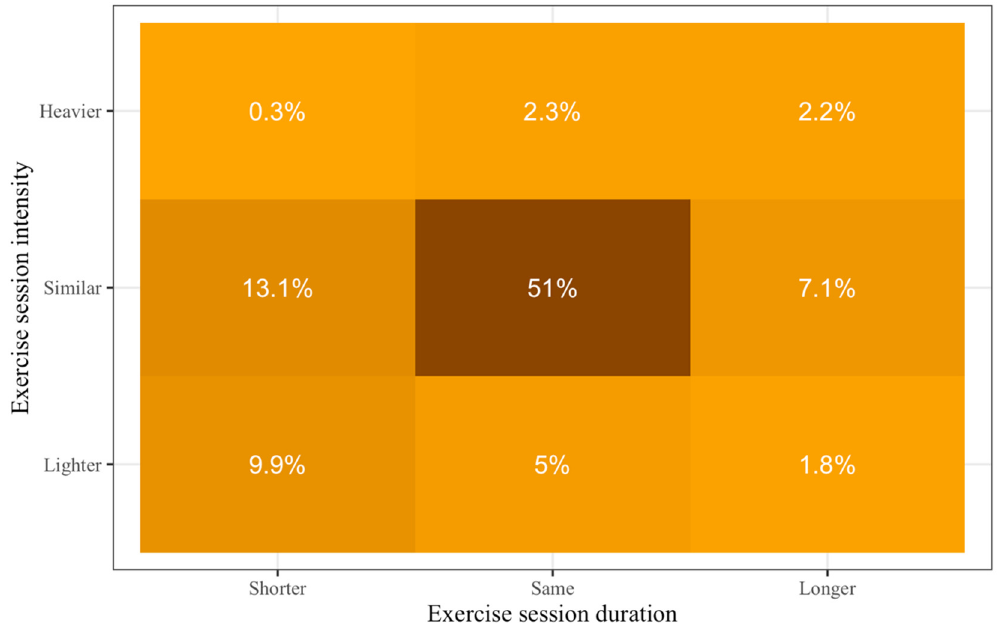
Figure 1. Changes in exercise levels during the Coronavirus disease 2019 (COVID-19) pandemic compared to prepandemic. Darker colors show higher percentages.